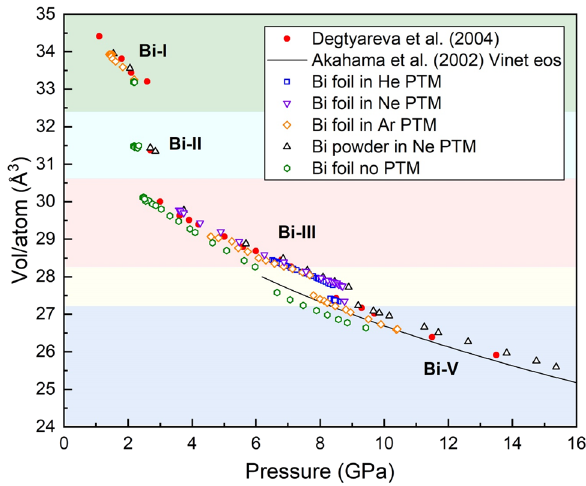
Figure 1. Volume/atom of Bi as a function of pressure for static compression experiments. Data were collected from Bi foil samples loaded in He, Ne, Ar, and without a PTM, and a powder sample loaded in Ne. The foil sample loaded without a PTM was prepared with the Au placed between the Bi and the diamond anvil. These data are compared with data from Degtyreva et al. 11 and the Vinet EOS for Bi-V from Akahama et al. 21